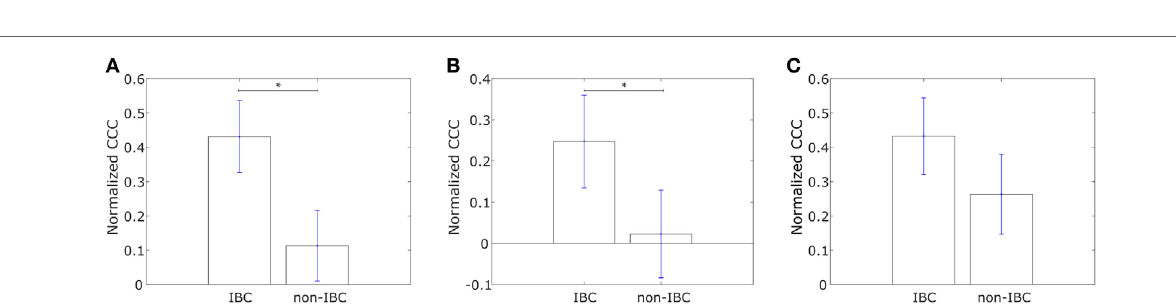
FigUre 3 | Normalized cophenetic correlation coefficient of the inflammatory breast cancer-associated gene network for (a) 13 epithelial (E) and 11 mesenchymal cell lines from the study by Grosse-Wilde et al. (39), and (B) 11 epithelial (E) and 47 hybrid epithelial-mesenchymal (E/M) + mesenchymal (M) cell lines from the NCI60 dataset (41, 42). Error bars indicate the SE in the estimate of CCC norm calculated using the bootstrap method. * p -Value <